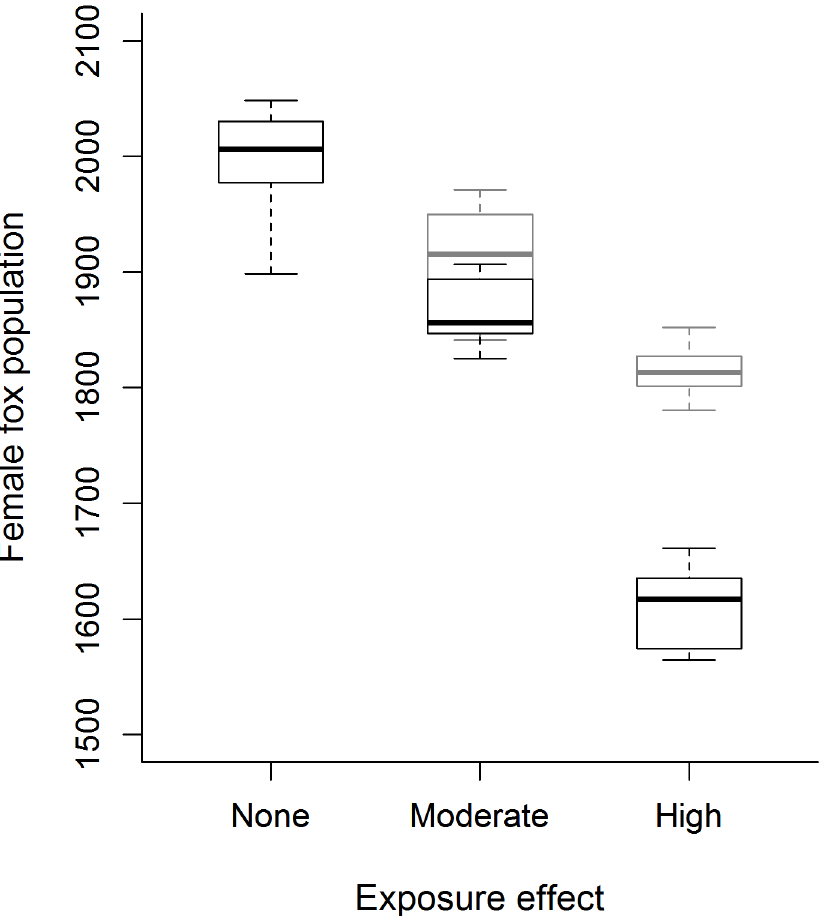
Fig 3. Impact of rodenticide application on kit fox population. Boxplot of impact of rodenticide application on female kit fox populations across 100 replicates. Black boxes indicate no-, moderate-, and high-effect scenarios. Grey boxes indicate moderate- and high-effect scenarios with no rodenticides in low-intensity development land cover class.